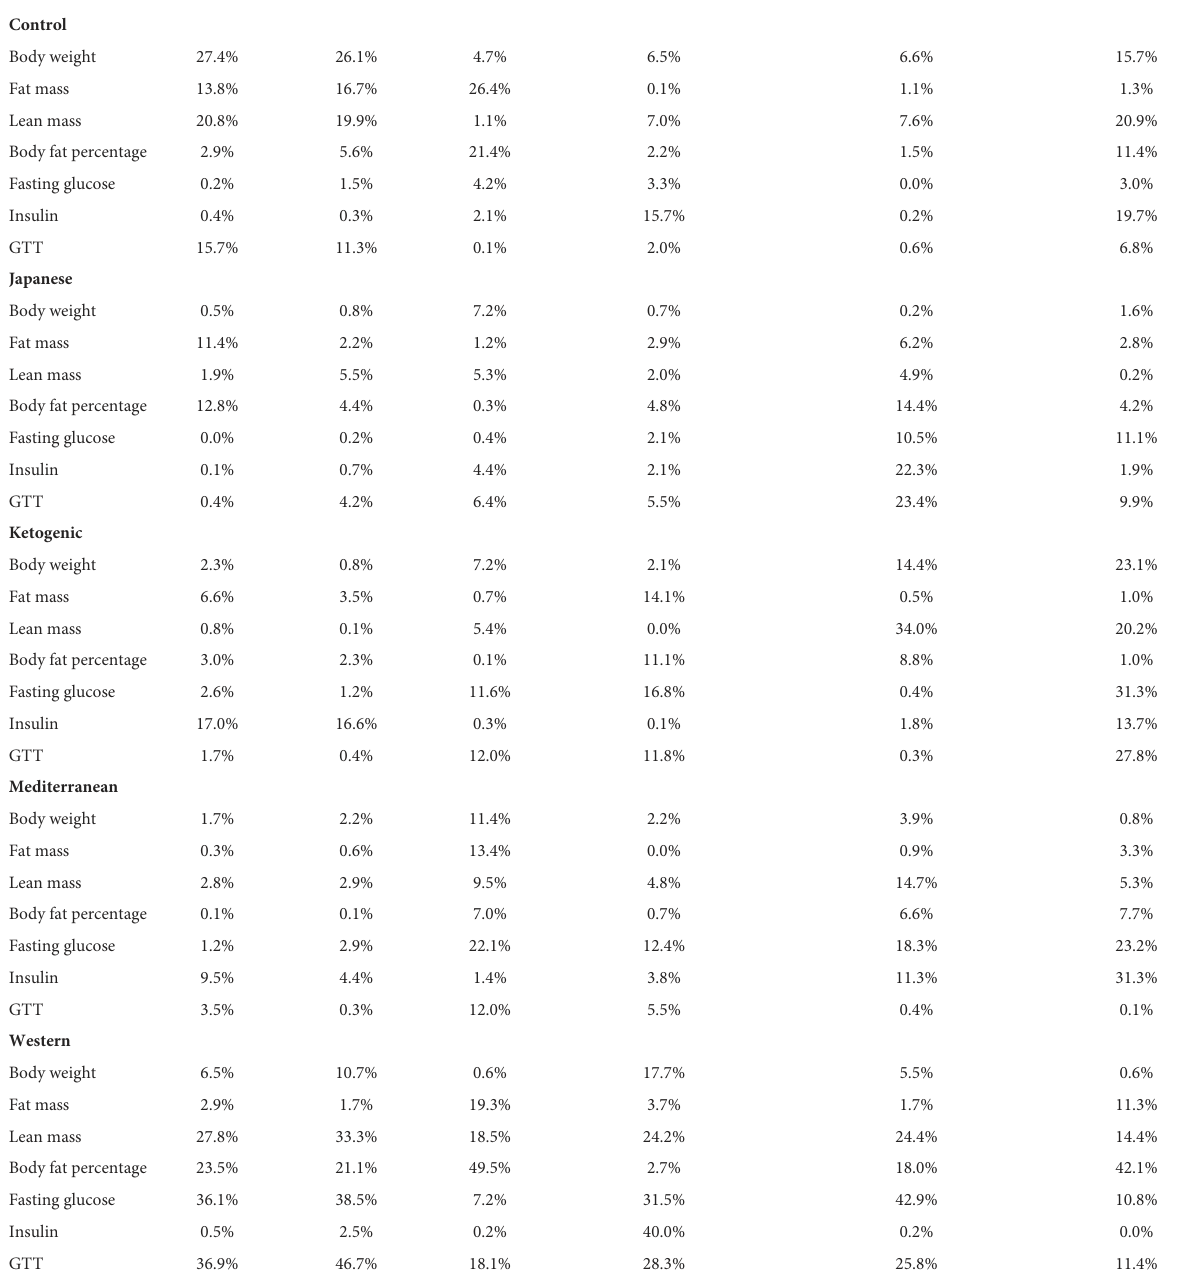
TABLE 1 Percent phenotypic variance explained by gut microbial alpha and beta diversity measures in each of the experimental diet.